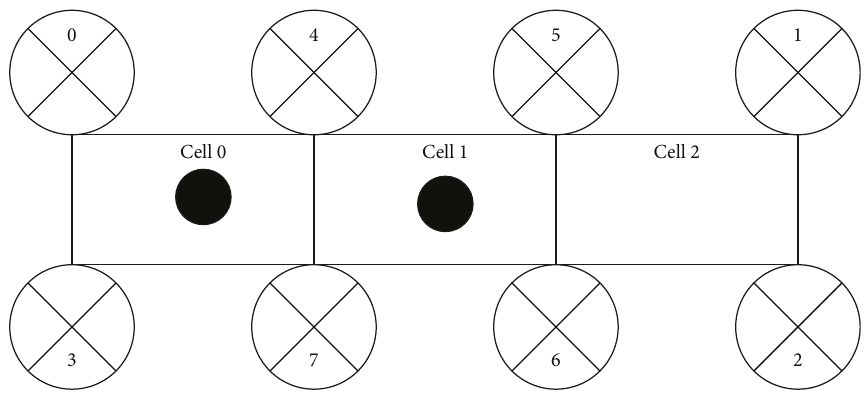
Figure 12: A distributed sensor network with eight sensors ⊗ and two targets ●